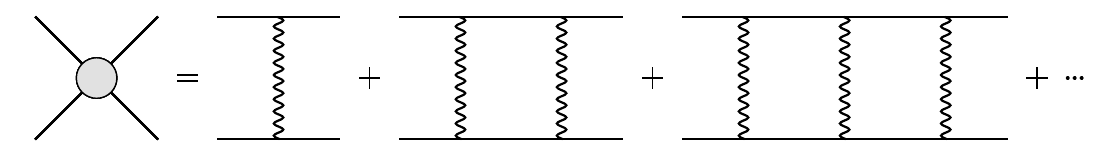
Figure 1 . Feynman diagrams in the fundamental theory for wino-wino scattering through the exchange of electroweak gauge bosons. The solid lines are neutral winos or charged winos, and the wavy lines are electroweak gauge bosons. If the winos are nonrelativistic, ladder diagrams from the exchange of electroweak gauge bosons must be summed to all